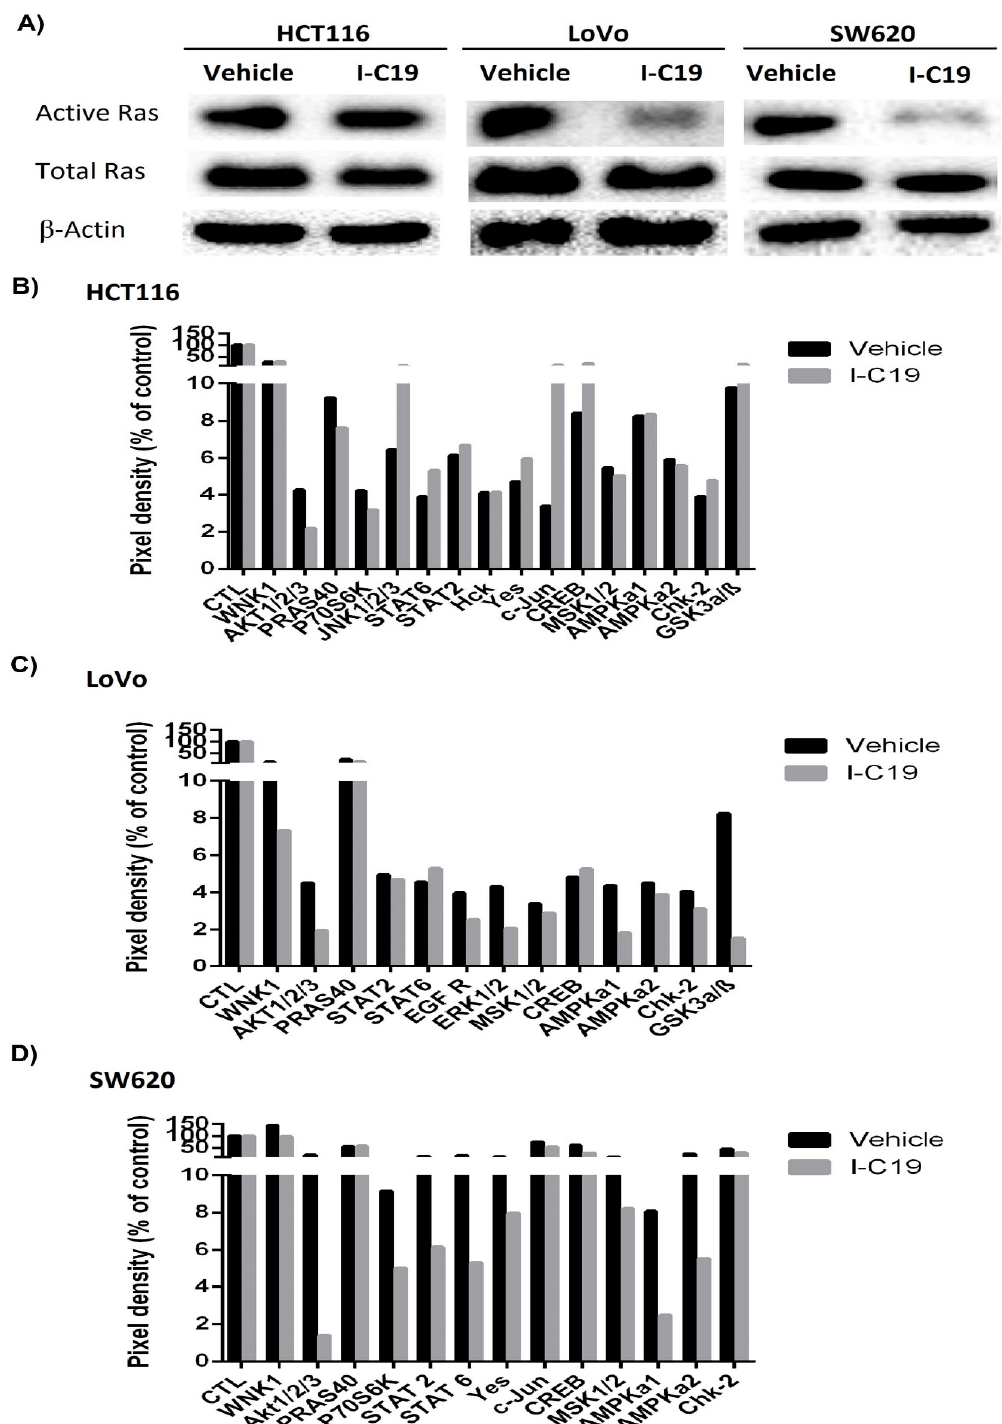
Figure 6. ( A ) RAS-GTP pull-down assay of three colorectal cancer cell lines treated with the vehicle and the IC 50 of I-C19 for 24 h, and the total Ras and β -actin were the loading controls (cropping blots); ( B ) human phospho-kinase array of the total protein extract of the colorectal cancer HCT116 cell line treated with the IC 50 of I-C19 for 24 h. ( C ) human phospho-kinase array of the total protein extract of the colorectal cancer LoVo cell line treated with the IC 50 of I-C19 for 24 h. ( D ) human phospho-kinase array of the total protein extract of the colorectal cancer SW620 cell line treated with the IC 50 of I-C19 for 24 h. Pixel density—% of